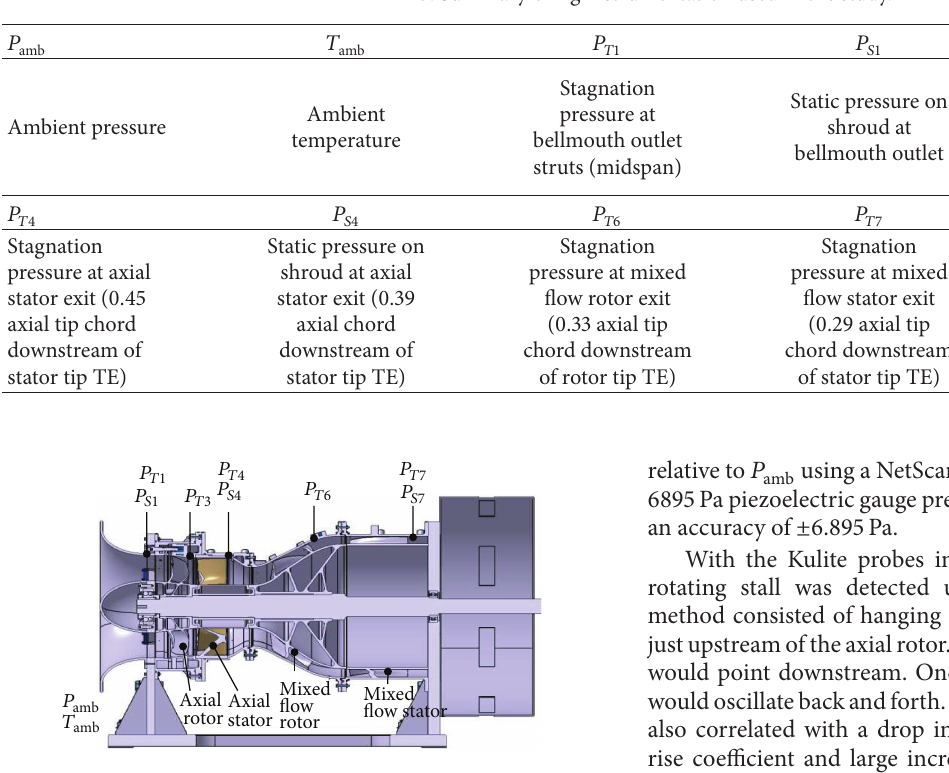
Figure 6: Cross section of compressor test rig with instrumentation used in the